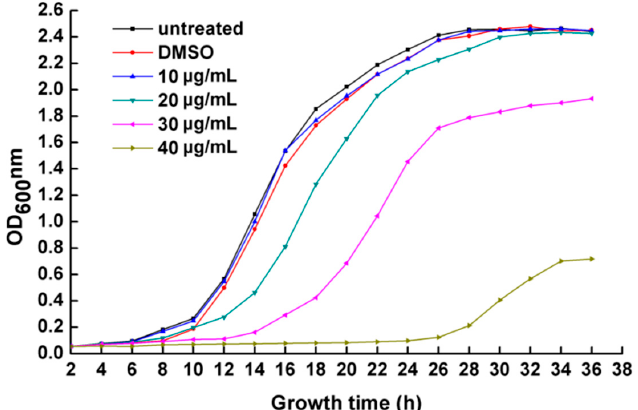
Figure 2. OD growth curves of R. solanacearum in the presence of different PCA concentrations at 30 °C. Untreated bacteria were treated with sterile water. Bacteria were also treated with DMSO alone at a fi nal concentration of 0.1%. The OD value of each treatment was the average of three replicates.